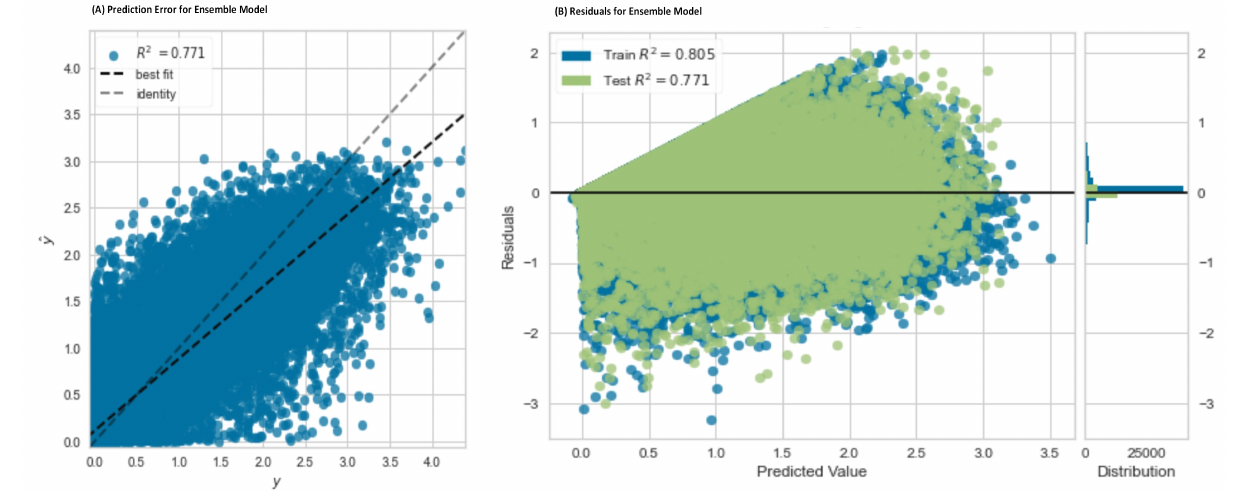
Figure 19. Accuracy of Ensemble Model for Rainfall forecasting.